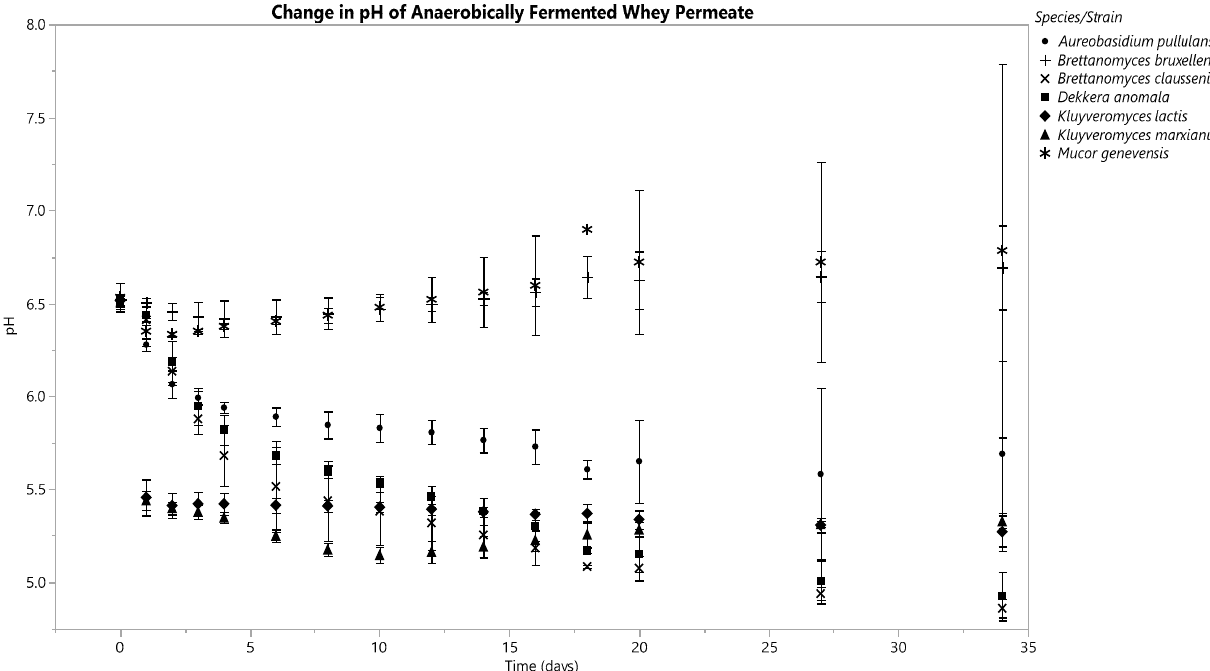
Figure 3. pH changes in the anaerobically fermented whey permeate were recorded every 4 h for each replicate. Data is displayed from D0, 1, 2, 3, 4, 6, 8, 10, 12, 14, 16, 18, 20, 27 and 34. Means are represented by data points and standard deviations by error bars, which were calculated from three replicates for each species besides M. genevensis , which had two viable replicates.